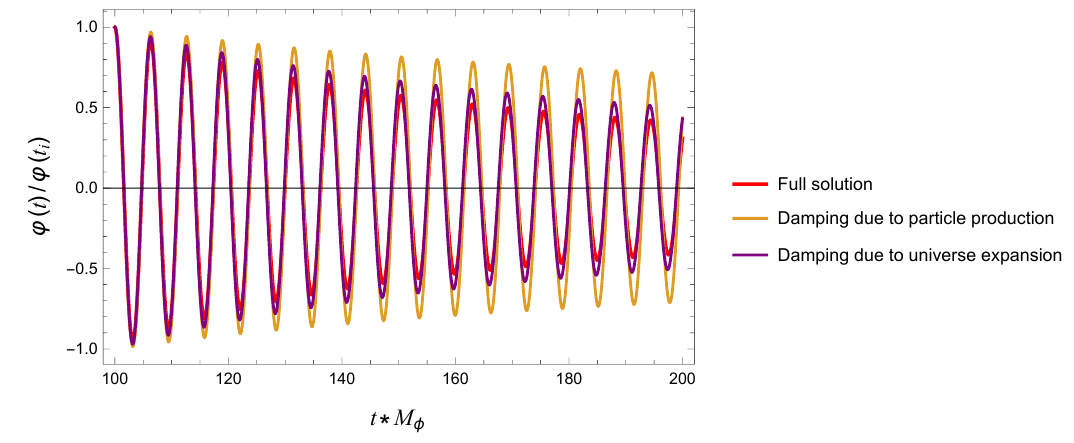
Figure 14 . Solutions of the condensate equation (2.24) with the imaginary part of the self-energy neglected γ = 0 . Analytic approximation in a matter-dominated universe, i.e., eq. (A.3a), is drawn in the red line with σ = − α = 0 . 01 /M ϕ , λ φ = 0 . 05 , γ = 0 , and µ = 0 . 001 M φ . Analytic approximation in a static universe with the same parameters, given by eqs. (3.38), is drawn in the brown line. Analytic approximation without interactions in a matter-dominated universe, i.e., eq. (A.2), is drawn in the purple line.